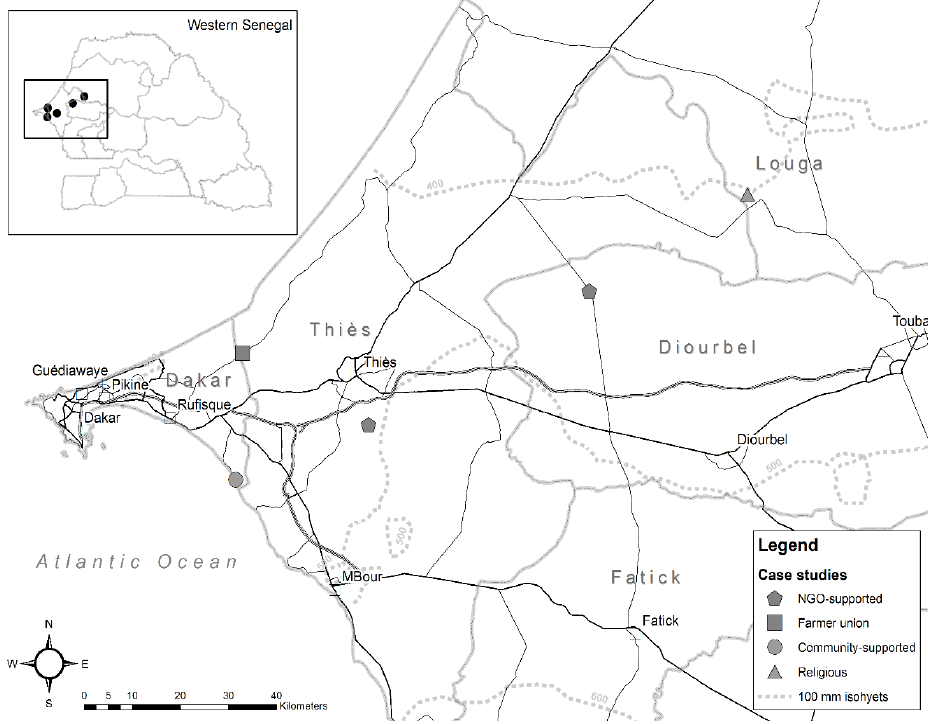
Figure 2. Localisation map of the four types of agroecological initiatives.